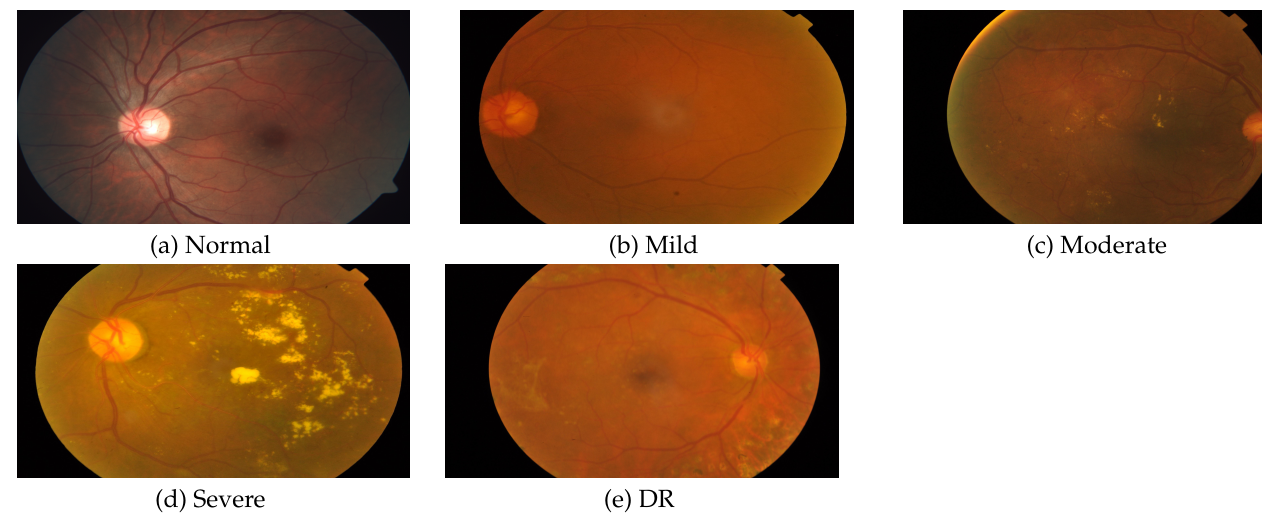
Figure 4. The five types of diabetic